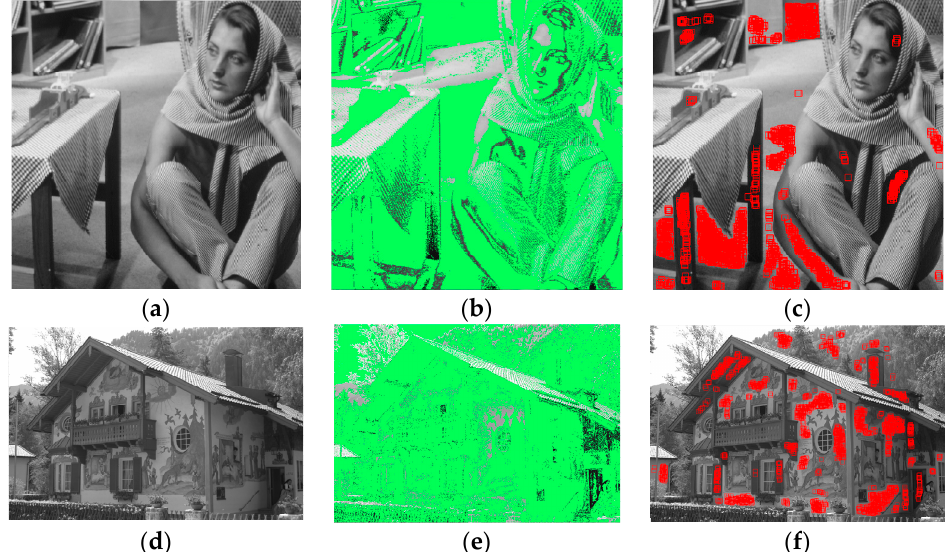
Figure 6. Two examples for homogenous blocks selection in the “Barbara” and “House.” ( a ) Original “Barbara” image; ( b ) the selected blocks after histogram constraint in “Barbara” image are labeled with green color; ( c ) 15 × 15 red boxes in the “Barbara” image have outlined the finally selected homogenous blocks; ( d ) original “House” image; ( e ) the selected blocks after histogram constraint in the “House” image are labeled with green color; ( f ) 15 × 15 red boxes in the “House” image have outlined the finally selected homogenous blocks.